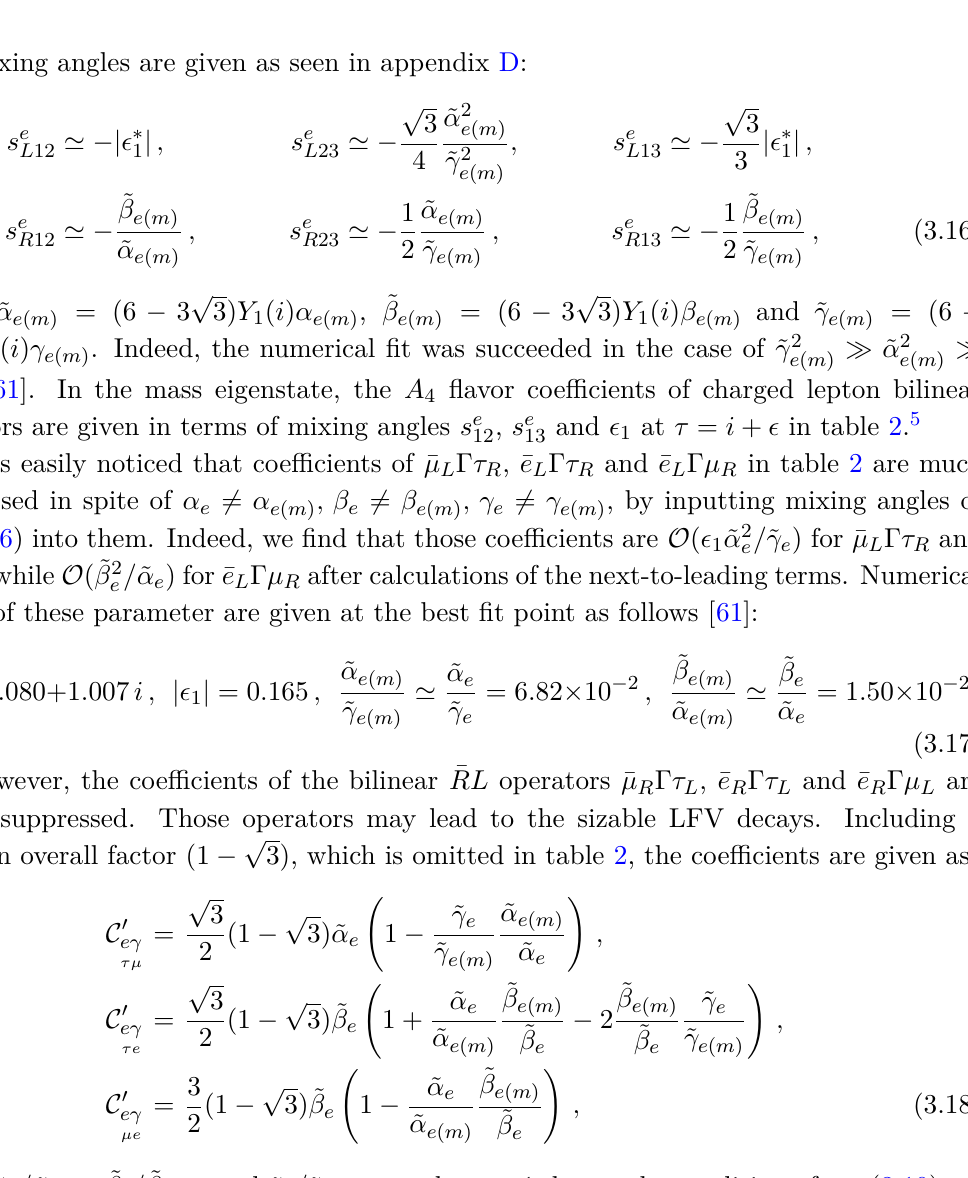
√ 3) Y 1 ( i ) α e , ˜ β e = (6